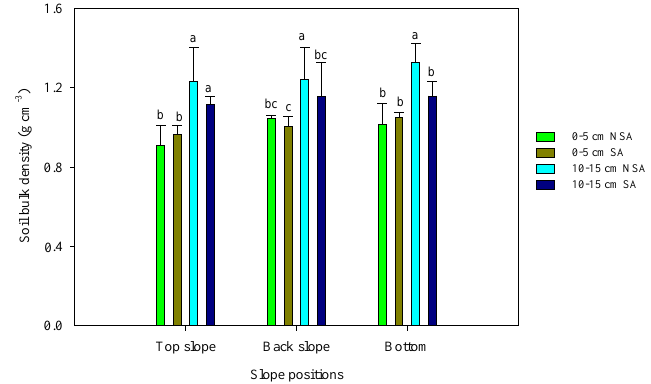
Figure 5. Soil bulk density before planting in spring of 2016. NSA and SA represent no straw amendment and amendment,